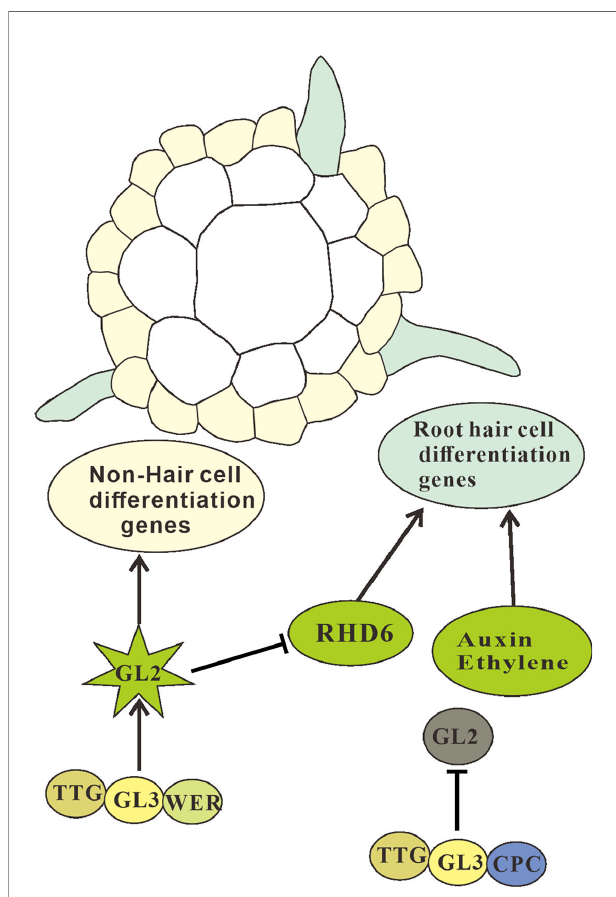
FIGURE 3 | Regulation of crucial components in root-hair development. Transverse section of Arabidopsis root showing the relative position of the epidermis and cortex. The epidermis cells are in the H cell position and emerge to form hair cells, and the epidermal cells beneath the cortex cells are in the non-hair cell (N) position and do not form root-hair cells. The root (H) and non-hair cell (N) positions have different components that participate in root-hair formation. Some components shuttle to different types of cells to converge at ROOT HAIR DEFECTIVE (RHD6), a bHLH factor, which when activated, controls the differentiation and formation of root-hair cells, and when non-activated, regulates non-hair-cell formation. Meanwhile, plant hormones such as auxins and ethylene play a positive role in root-hair formation via reactive oxygen species (ROS). Arrow-head line indicates stimulation effect, and “ T ” -shaped line shows the